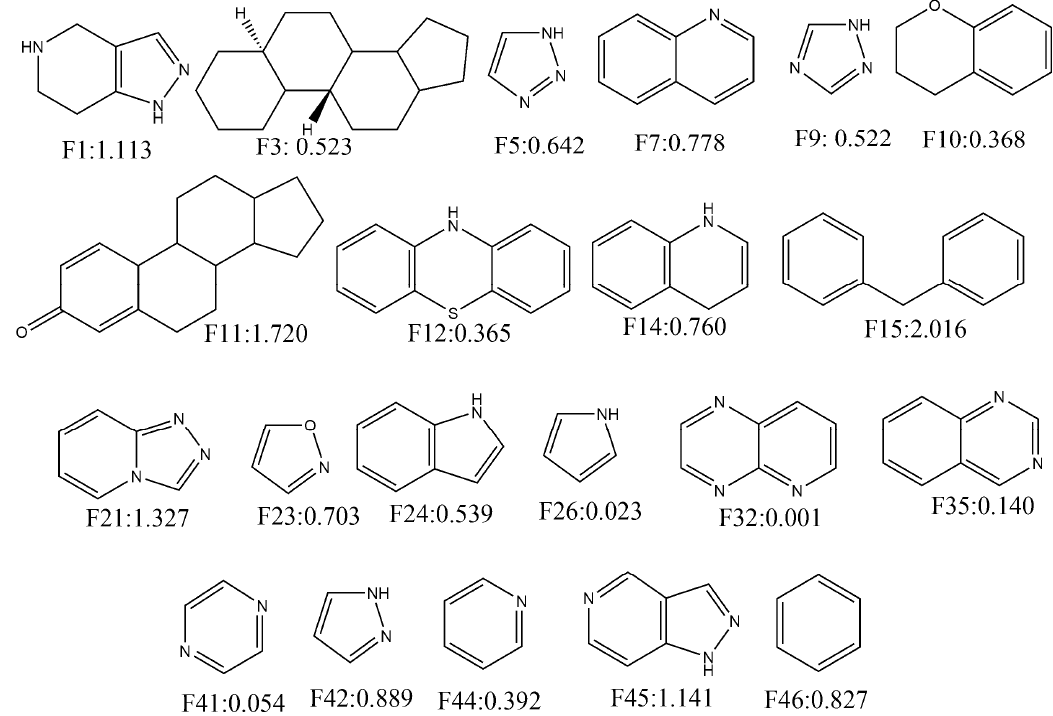
Figure 4. Fragments depicting positive contribution for extracellular regulated kinase (ERK)-1 / 2 inhibition with their average confidence scores.